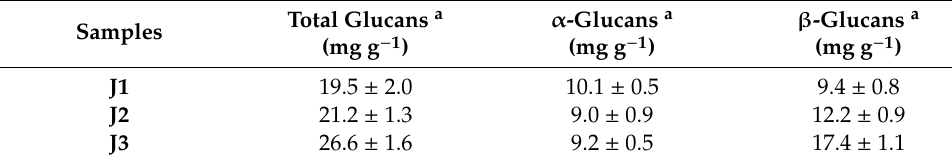
Table 4. α - and β -Glucan content from jujubes.